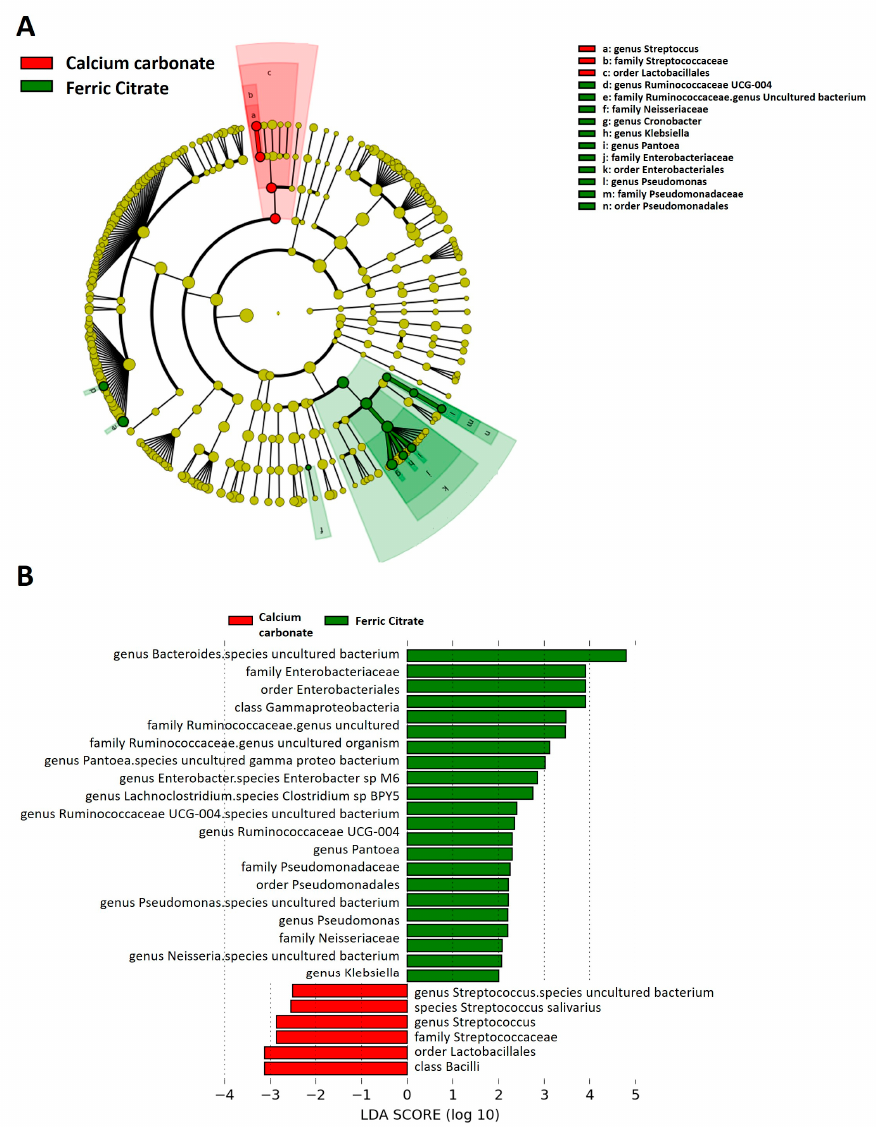
Figure 2. Linear discriminant analysis Effect Size (LEfSe) showing microbiome differences between ferric citrate and calcium carbonate phosphate binder users at various taxonomic levels. ( A ) Cladogram demonstrating microbiome differences at various phylogenic levels, ( B ) LEfSe analysis with linear discriminant analysis (LDA) score representing statistical and biological differences in taxa between groups. Green indicates taxa enriched in a ferric citrate group and red indicates taxa enriched in a calcium carbonate phosphate binder group.